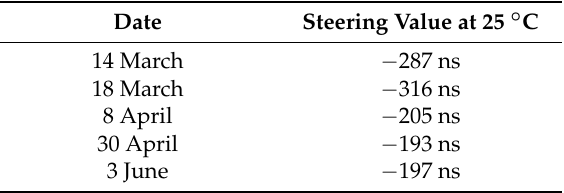
Table 5. Obtained steering values at 25 ◦ C.